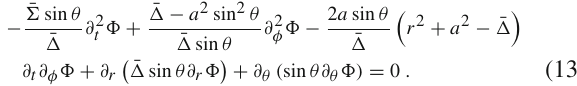
may recall the case with η = 0 first. It can be shown that